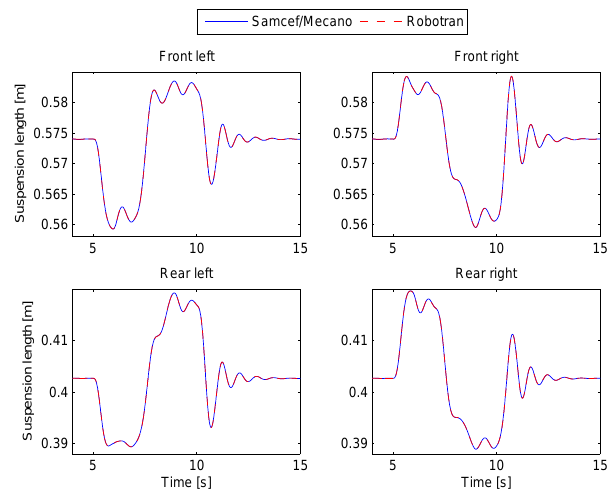
Figure 15. Suspension crushing during a line change